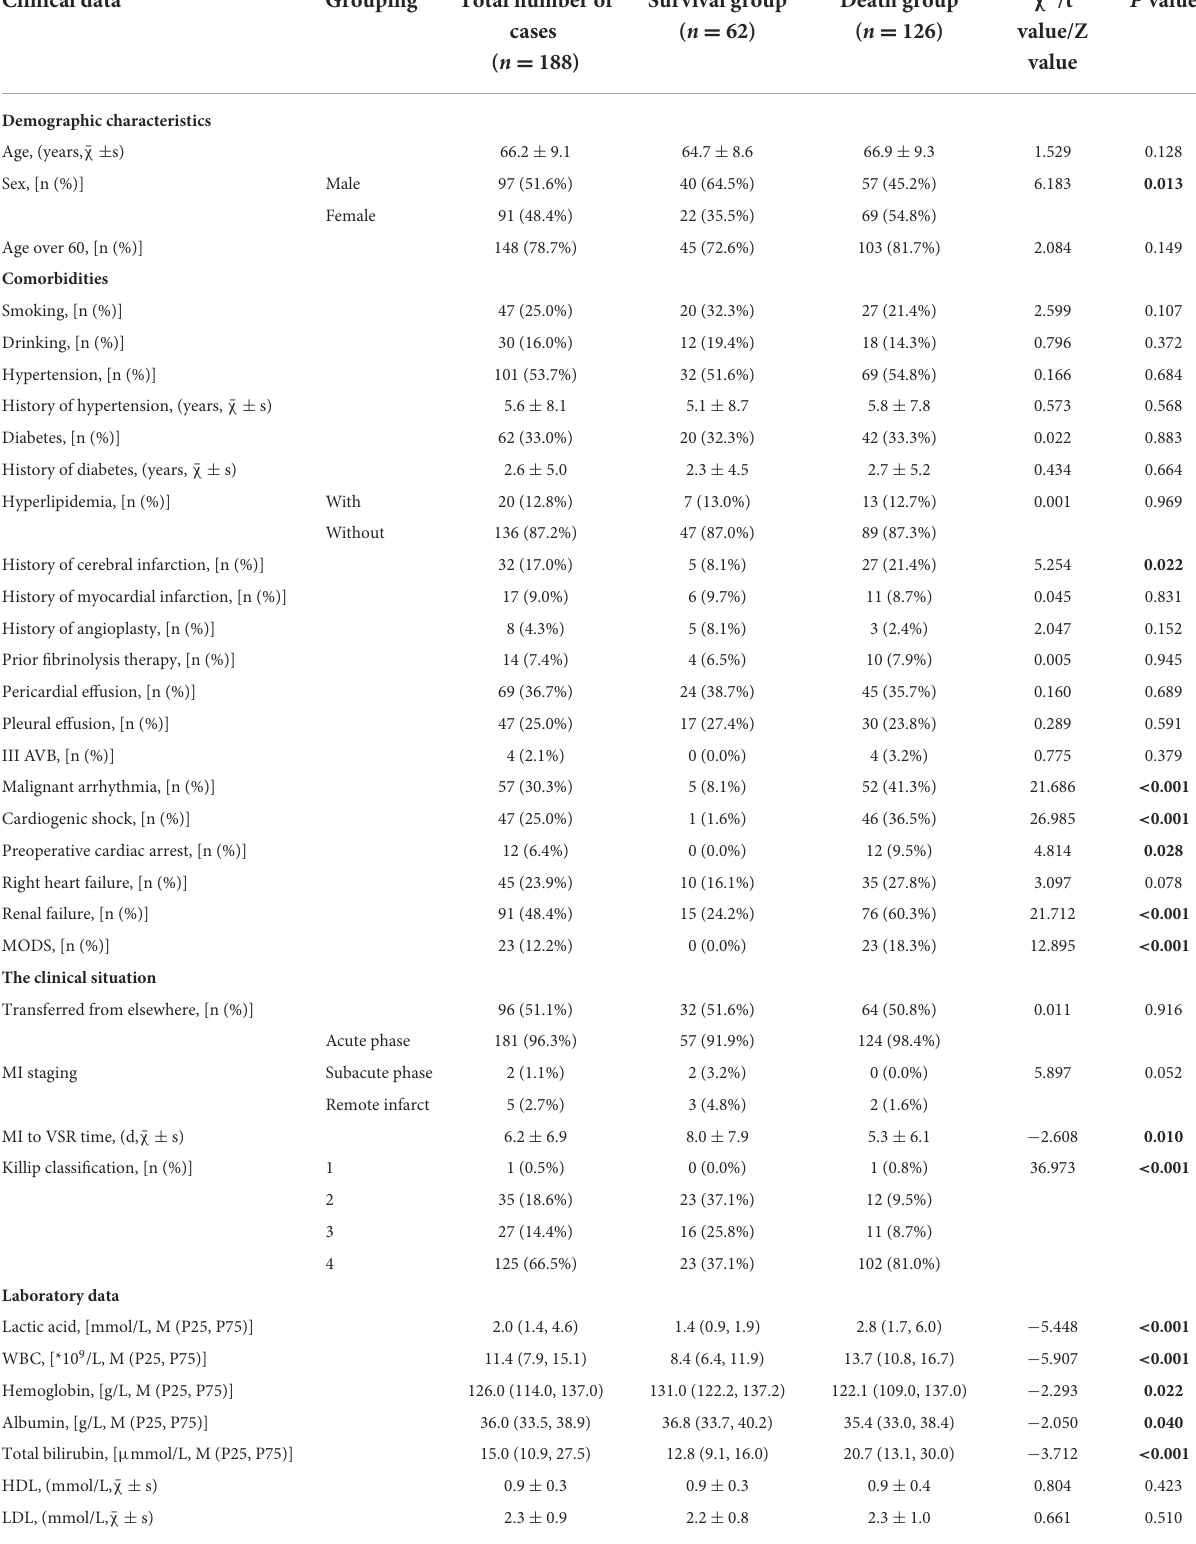
TABLE 1 Clinical data of VSR patients stratified by different prognosis. Clinical